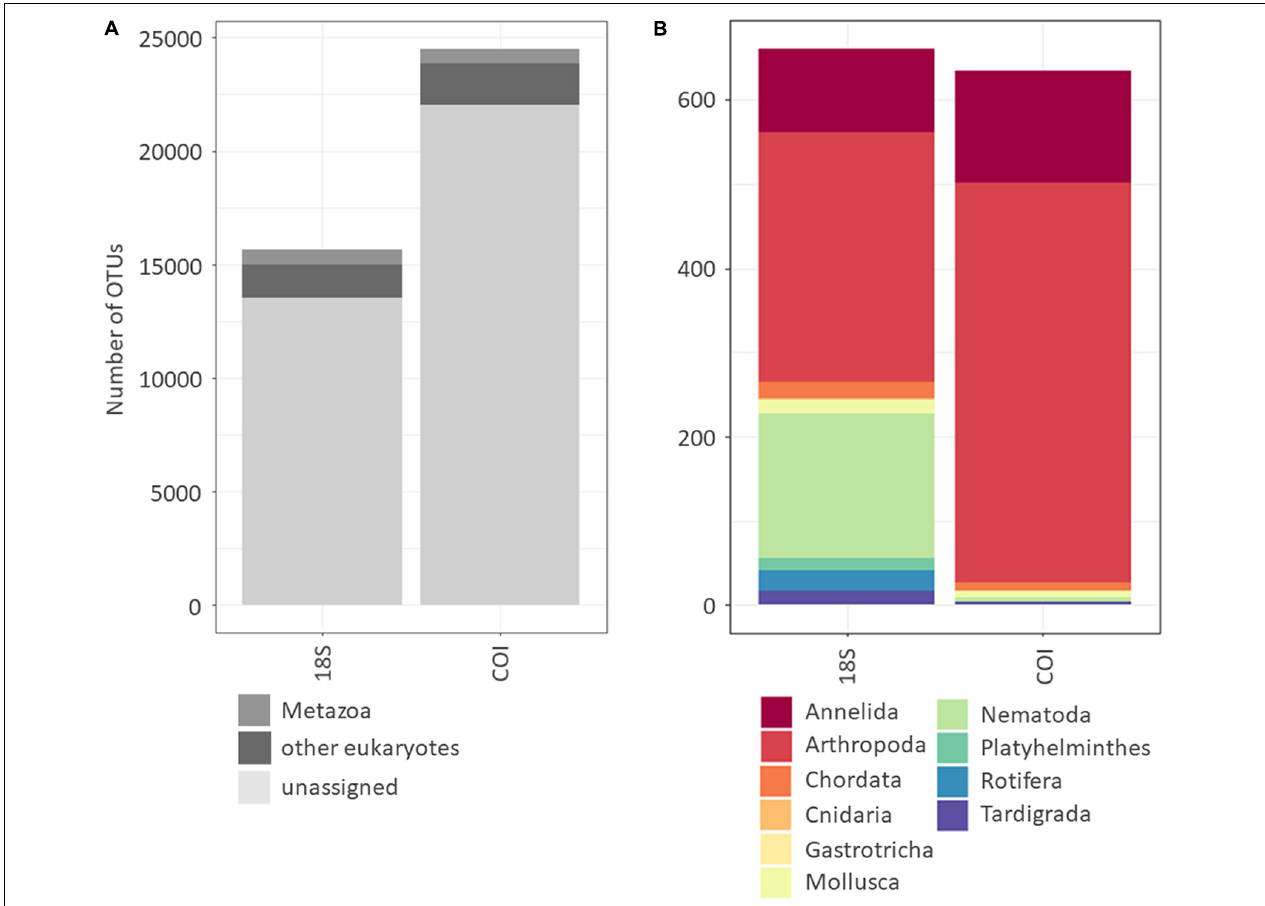
FIGURE 1 | Number of OTUs per gene marker used (18S and COI) assigned to Bacteria, Metazoa and remaining Eukaryotes consisting of Fungi, Chromista, Protozoa, Plantae (blastID ≥ 97%). The number of unassigned OTUs is indicated in light gray (A) . Number of OTUs assigned to Metazoa on phylum level (blastID ≥ 97%)